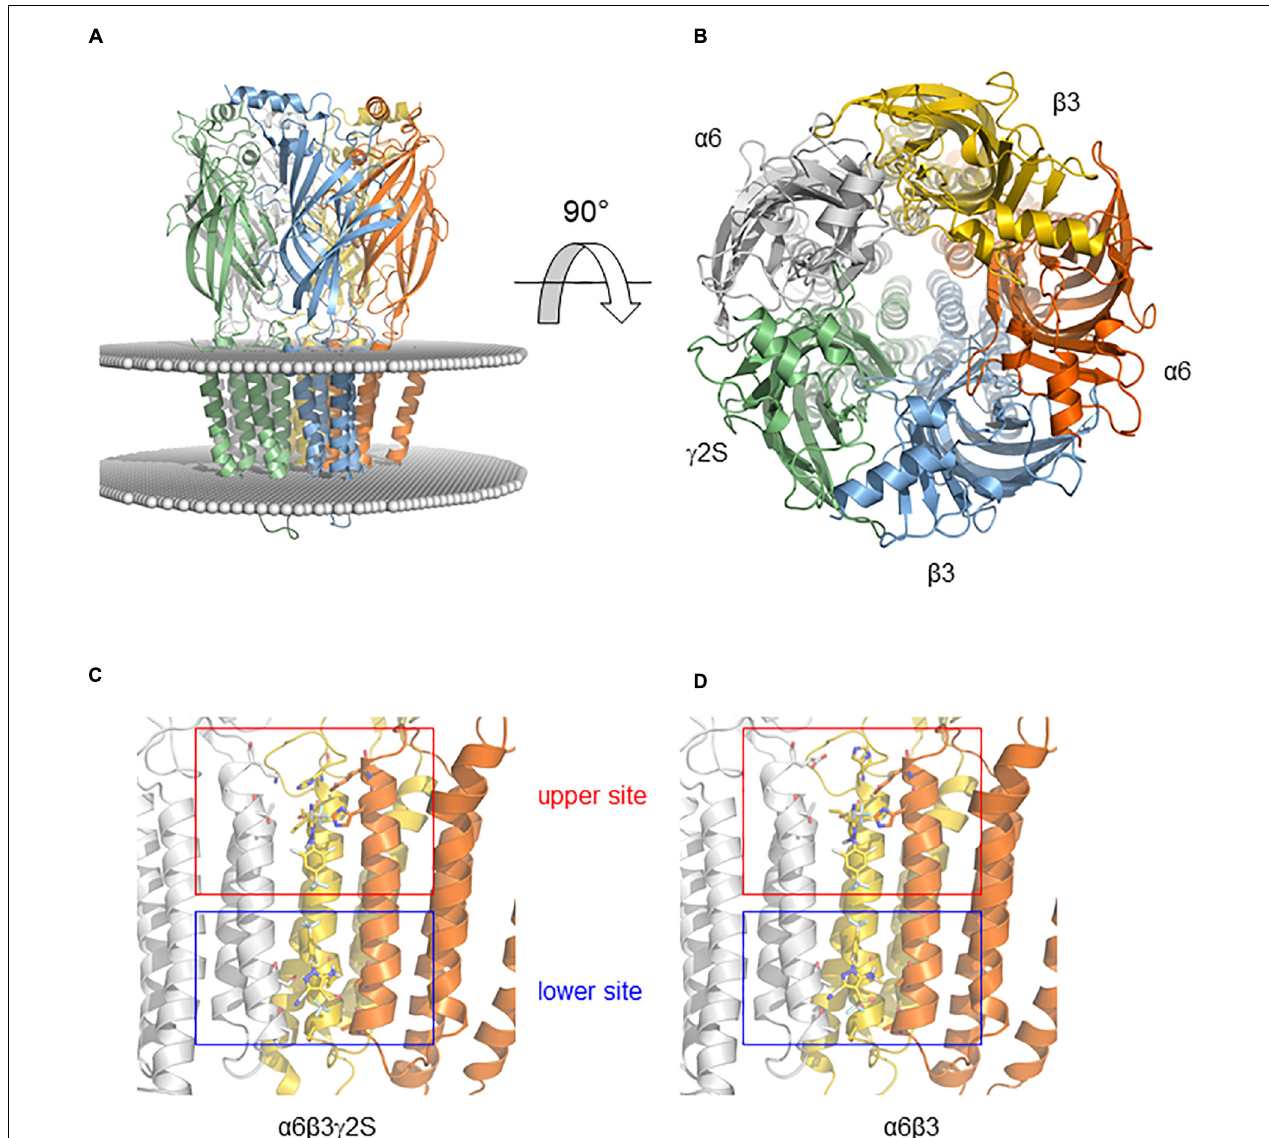
FIGURE 7 | Binding modes of FPN obtained by docking on the mouse α 6-containing GABA A R. (A) Model of the receptor viewed from the membrane plane. The protein is shown in cartoon representation with a different color code for each polypeptide. The position of the membrane is represented by a sphere positioned at the level of lipid head groups as determined by the Orientations of Proteins in Membranes database. (B) Model of the receptor viewed from above the membrane (rotation of 90 ◦ from A ). (C,D) Binding modes of FPN obtained by docking on the mouse α 6 β 3 γ 2S (C) and α 6 β 3 (D) GABA A Rs. Close-up showing the FPN-binding pocket (FPN appears in sticks). FPN interacts with an upper site (Ser272)—nearby the extracellular part of the membrane—and the second site (Val257)—located near the intracellular part of the